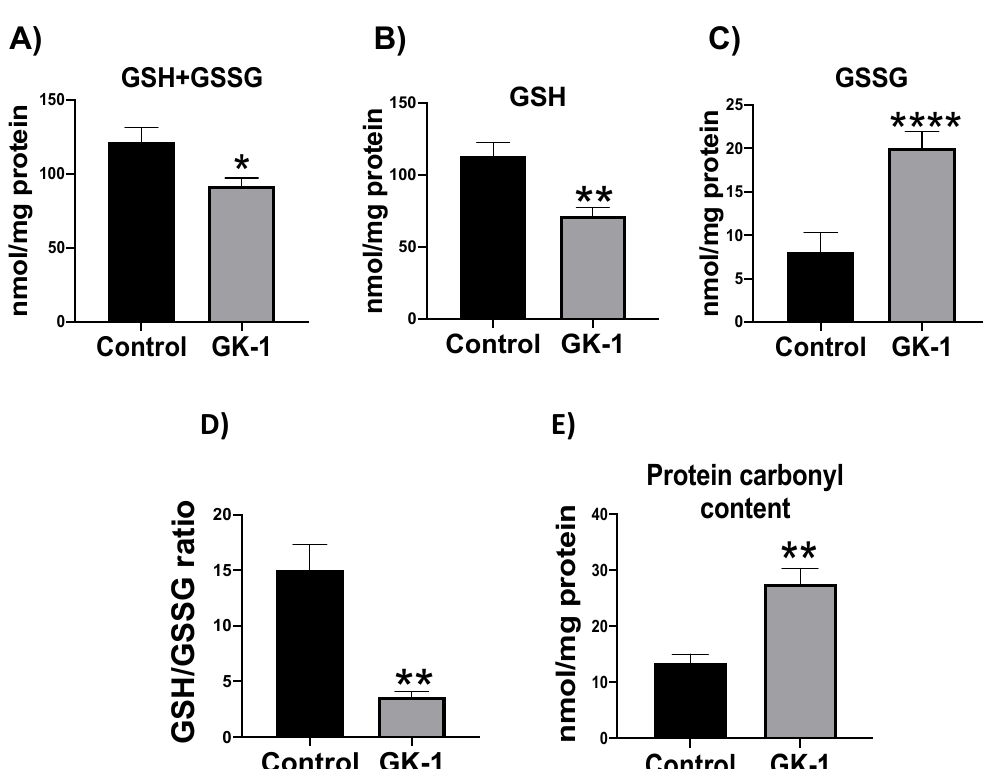
Figure 4. GK-1 stimulates OS and oxidative damage in TNBC. ( A ) Total glutathione (GSH+GSSG), ( B ) reduced glutathione (GSH), ( C ) glutathione disulfide (GSSG), ( D ) GSH/GSSG ratio, and ( E ) protein carbonyl levels in comparison with the control. t -Student test, control vs. GK-1, * p < 0.05, ** p < 0.005 and **** p < 0.00005. The results are expressed as the mean ± SEM, n = 5.